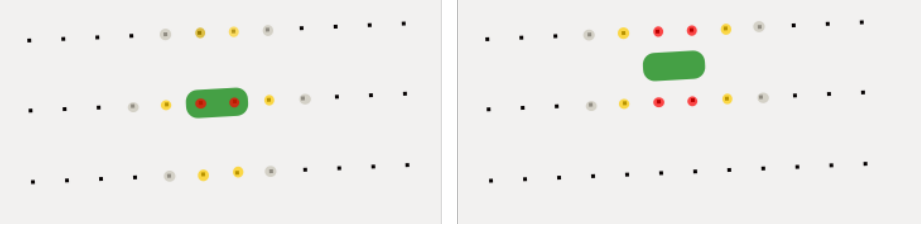
Figure 5. Examples of the k-nearest neighbors (k-NN) lane positioning method. ( left ) Vehicle moving in the lane; ( right ) Vehicle between two lanes.